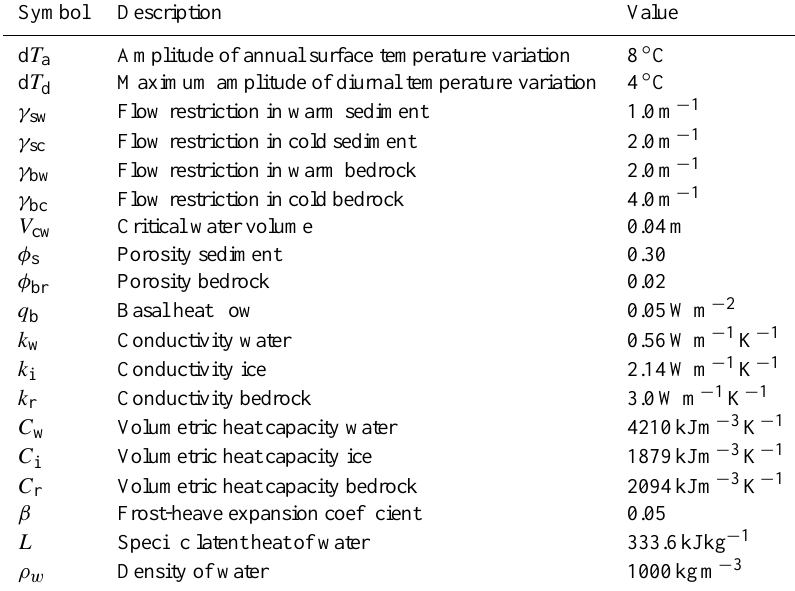
Table 1. Model parameters. These values apply to all model results unless otherwise